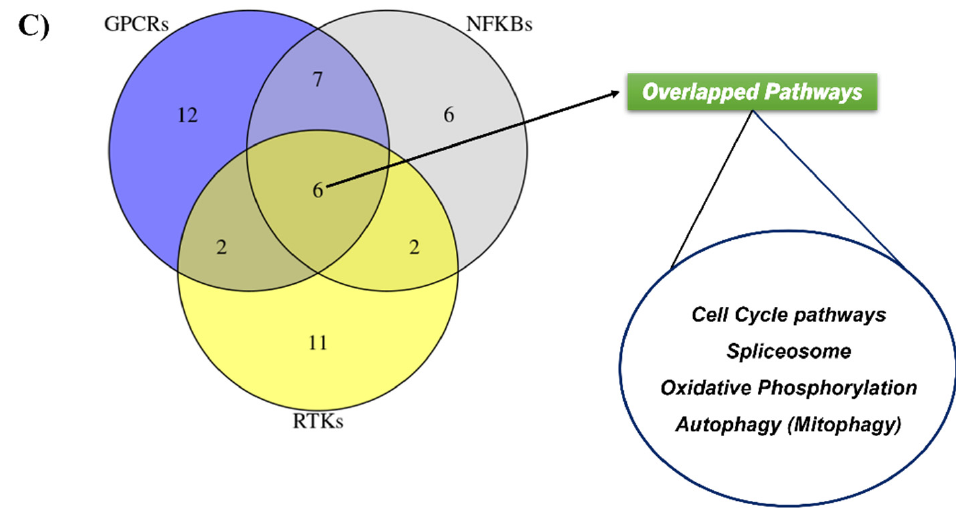
Figure 2. Integration analysis of GSEA-CMAP. ( A ) Graphical summary of the GSEA-CMAP inte- gration analysis. ( B ) Top-ranked 10 CMAP compounds that induce transcriptional alterations similar to (indicated by positive similarity score) SSRE treatment of A549 cells. ( C ) Venn Diagram describing the overlapped pathways of three classes of compounds (RTKs, NFKBs, GPCRs).